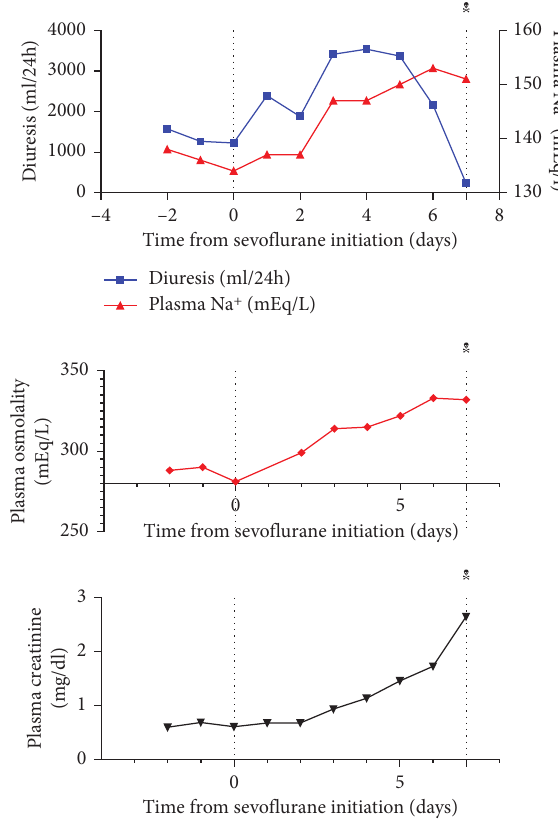
Figure 1: Laboratory